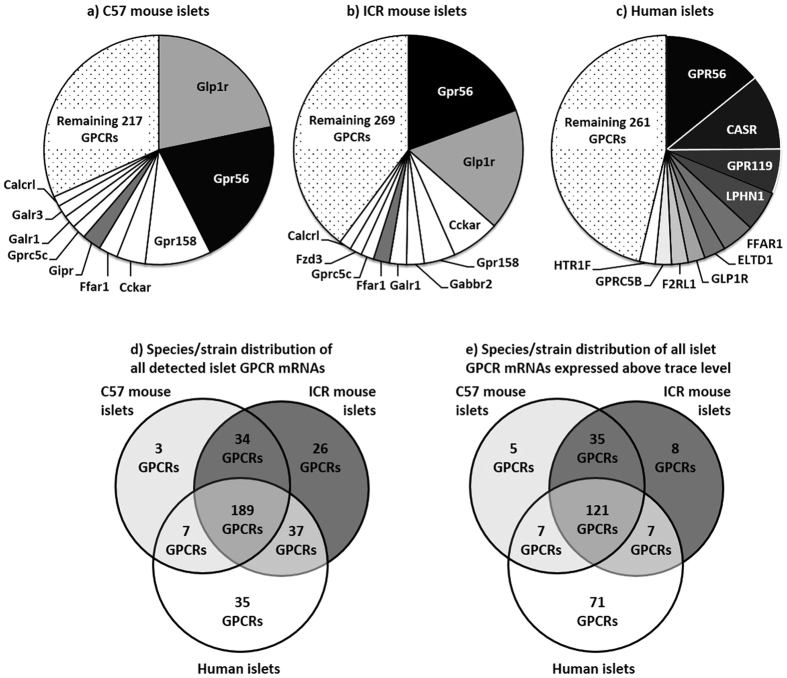
Summary of the relative expression of the ten most abundant GPCR mRNAs in outbred ICR mouse islets (a), inbred C57 mouse islets (b) and human islets (c). Colour coding in mouse islets according to similarities with human islet GPCR expression. White fields represent mouse islet GPCR mRNAs that are not among the ten most abundant GPCR mRNAs in human islets. Data for each GPCR are presented as mean % of the mRNA expression of all GPCRs in each islet type. (d,e) Species/strain distribution of all islet GPCR mRNAs in C57 and ICR mouse islets and human islets with all GPCR mRNAs (d) and only with GPCR mRNAs expressed above trace level (e).